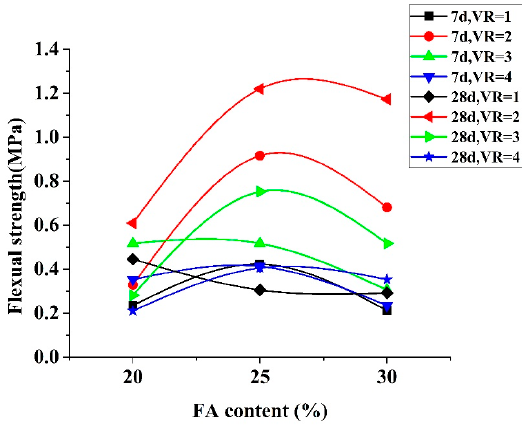
Figure 8. Test result of flexural strength of the specimen (VR: the volume ratio).